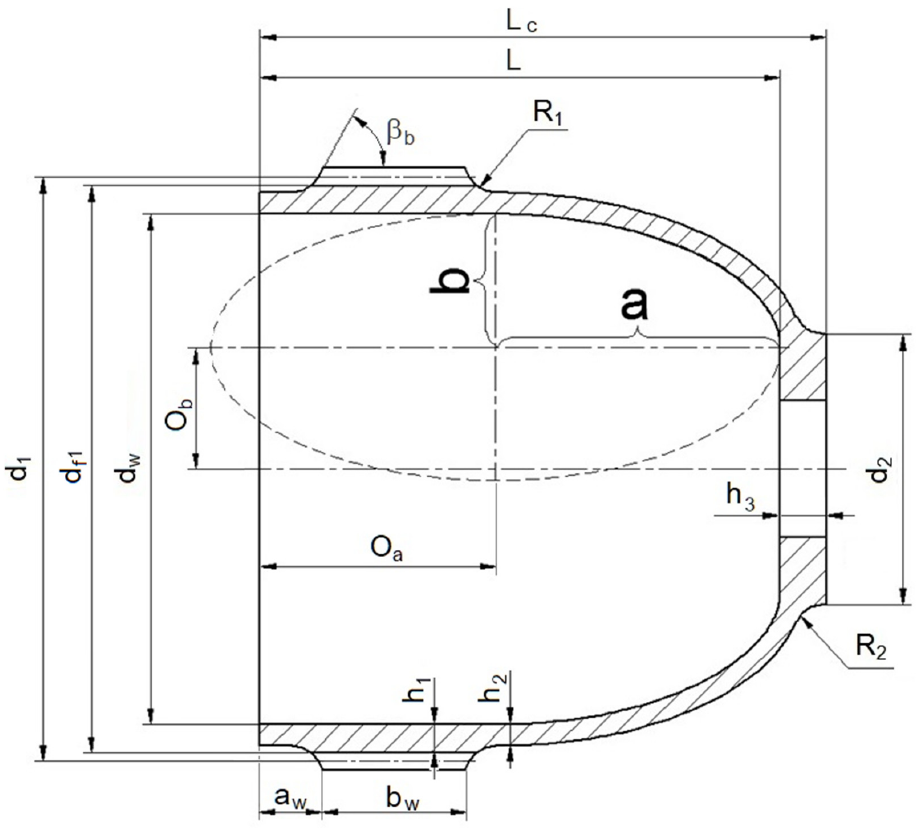
Figure 15. New shape of the flexspline of harmonic drives (variant X). Table 2. Main geometric parameters for the new shape of flexspline (variant X), where: z 1 = 198, m 1 = 0.76, 2ℎ 𝑎∗ —tooth head height factor, 𝑐 ∗ —tip clearance factor.